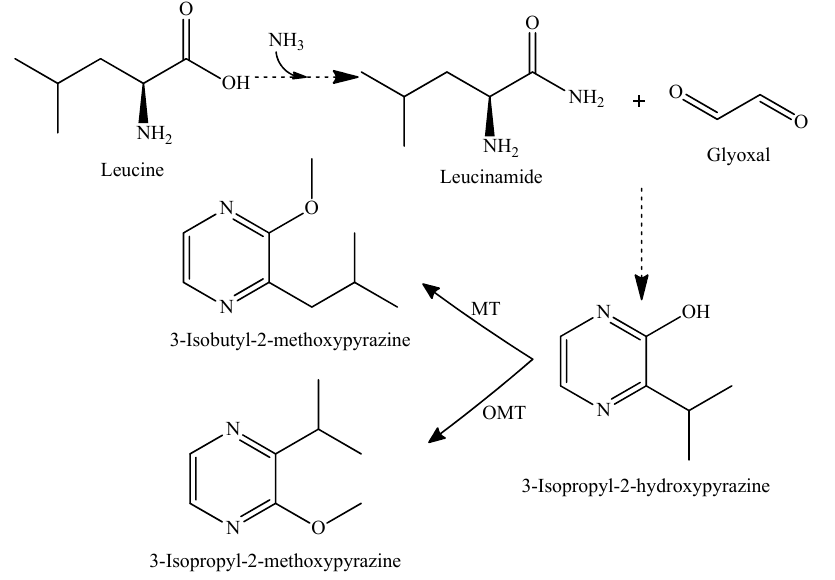
Figure 4. Proposed pathway for the biosynthesis of 3-isobutyl-2-methoxypyrazine and 3-isopropyl-2- methoxypyrazine [47,48]. MT, methyltransferase; OMT, O-methyltransferase.